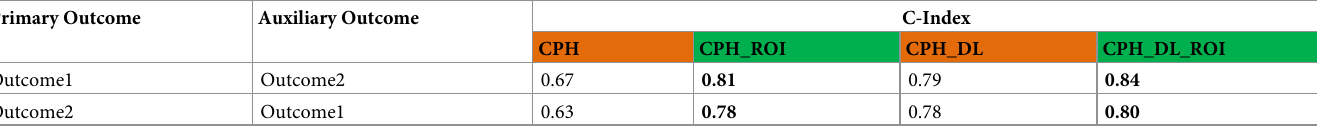
Table 3. TTE prediction model performance comparison on synthetic